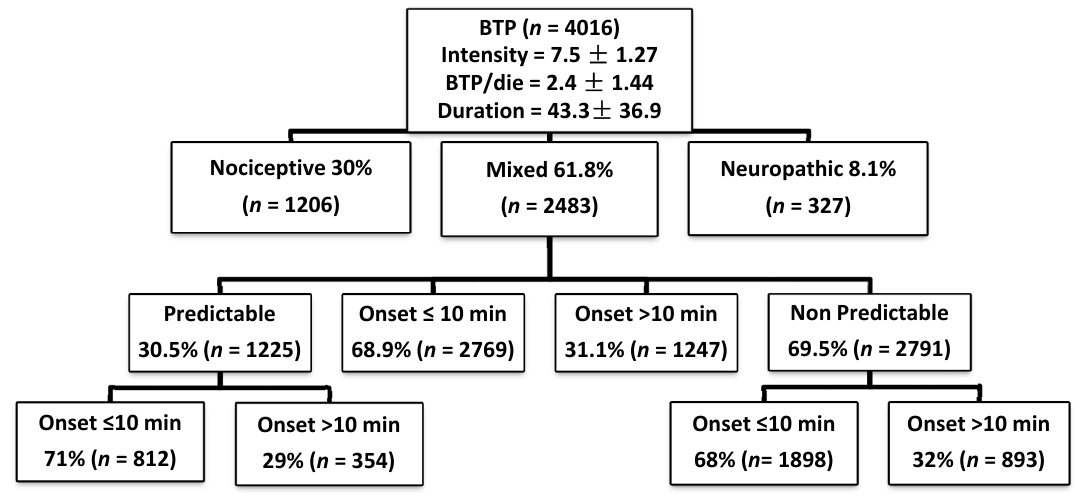
Figure 1. Characteristics of breakthrough cancer pain (BTP).